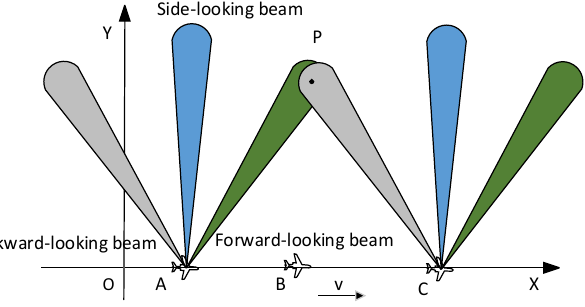
Figure 1. Model of multi-angle SAR imaging system.